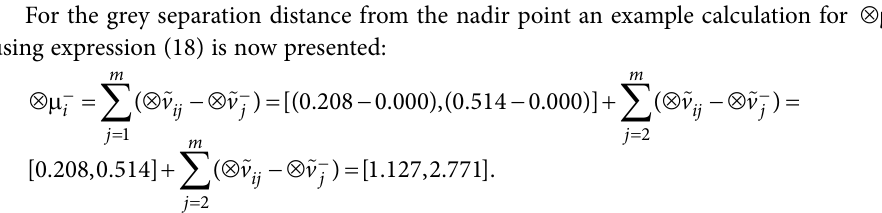
The final grey separation distances from the ideal point for each supplier are summarized in Table